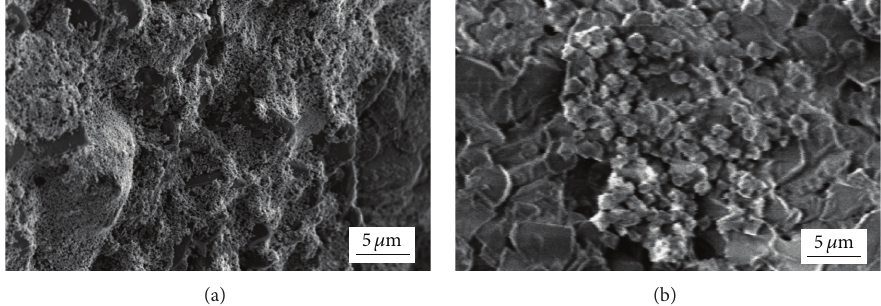
Figure 5: SEM micrographs of samples with 20 wt% Ni loading: (a) oxide precursor for Ni on the foam surface and (b) Ni on the foam surface, obtained after reduction of oxide precursor at 633 K.